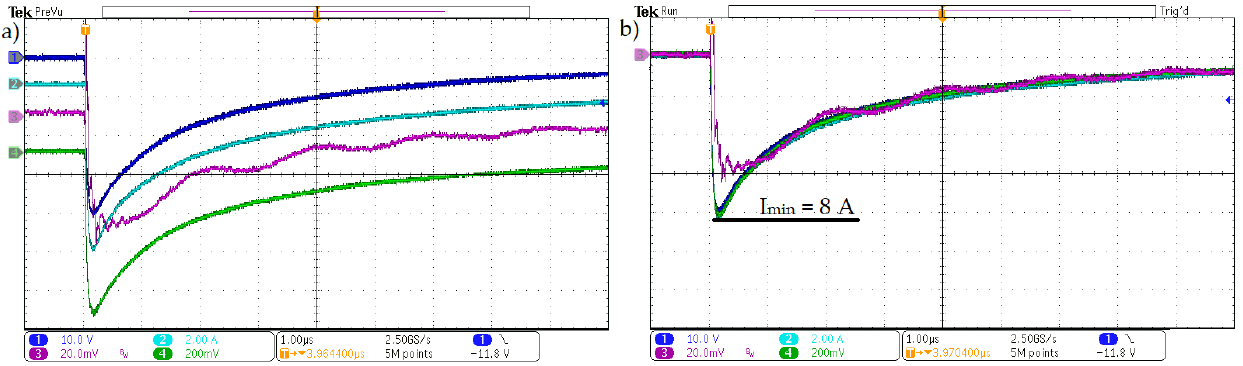
Figure 8. ( a ) Measured current signal vs time (1 μs/div)—CH1: CSR with passive probe TPP1000, CH2: TCP0030A, CH3: Hall sensor LA55-P with a Bandpass Filter of 20 MHz, CH4: ALCS. ( b ) All aligned signals are presented.